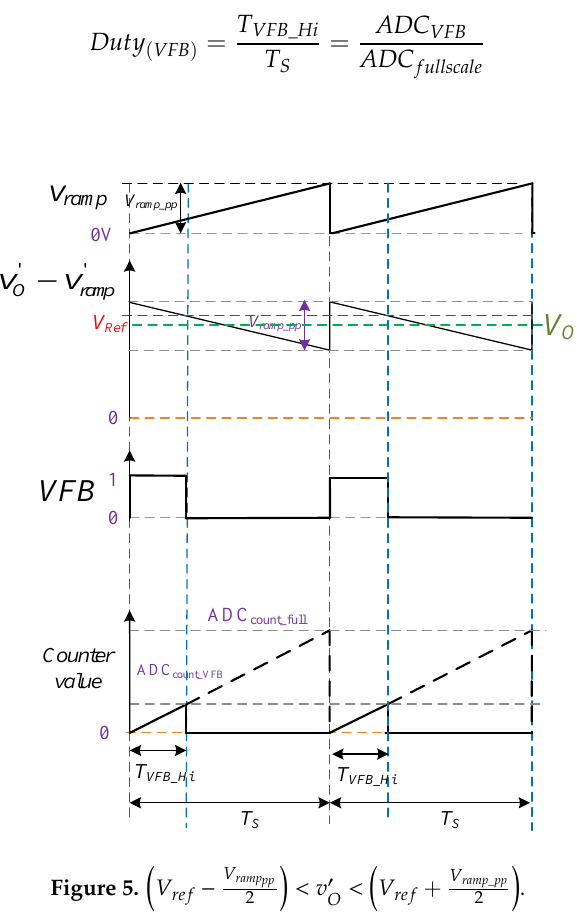
(cid:18) Figure 5. . V ramppp V ref − Figure 5.